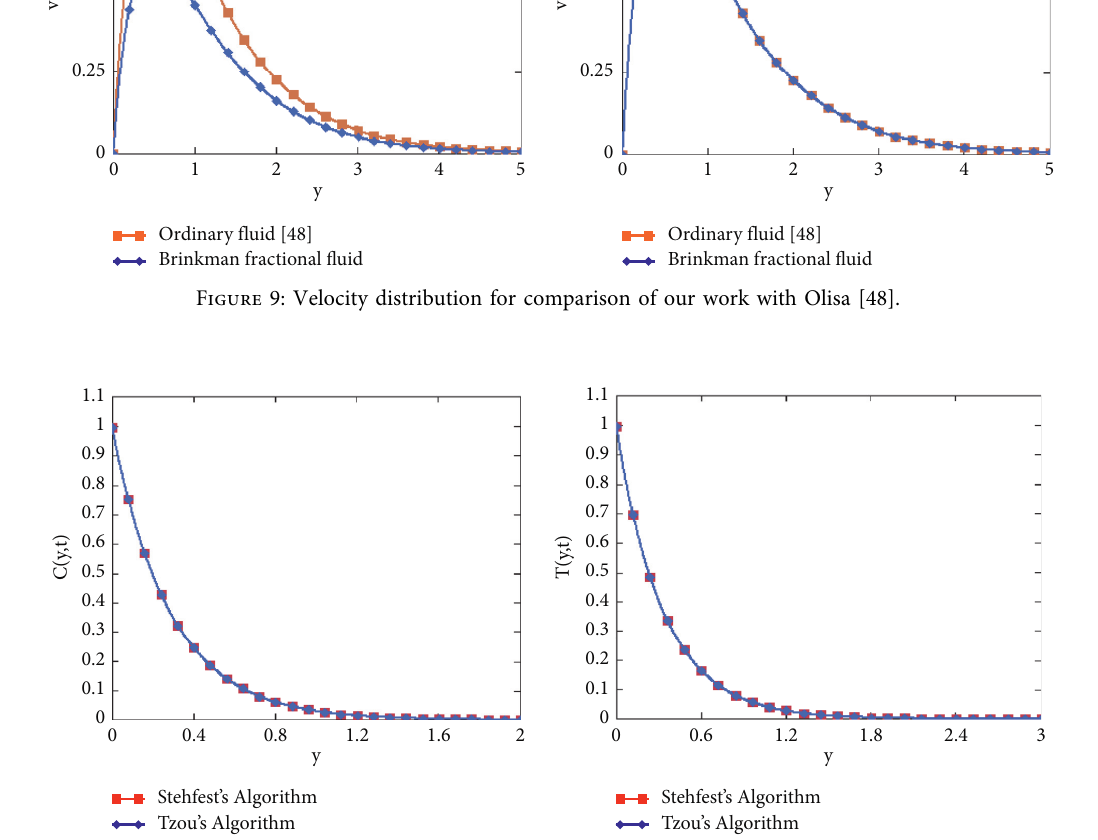
Figure 10: Concentrations and temperatures obtained by Stehfest’s and Tzou’s algorithms.